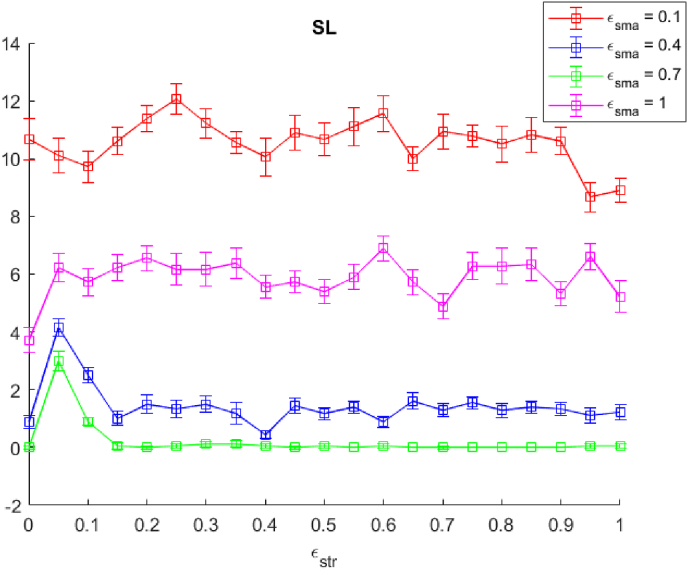
Set Loss errors as a function of εstr, for four different values of εsma. Note that set loss errors are largely independent of εstr, but are high at extreme values of εsma. When εsma is 0.7 set loss errors are negligible except at very low values of εstr. Error bars show one standard error from the mean.